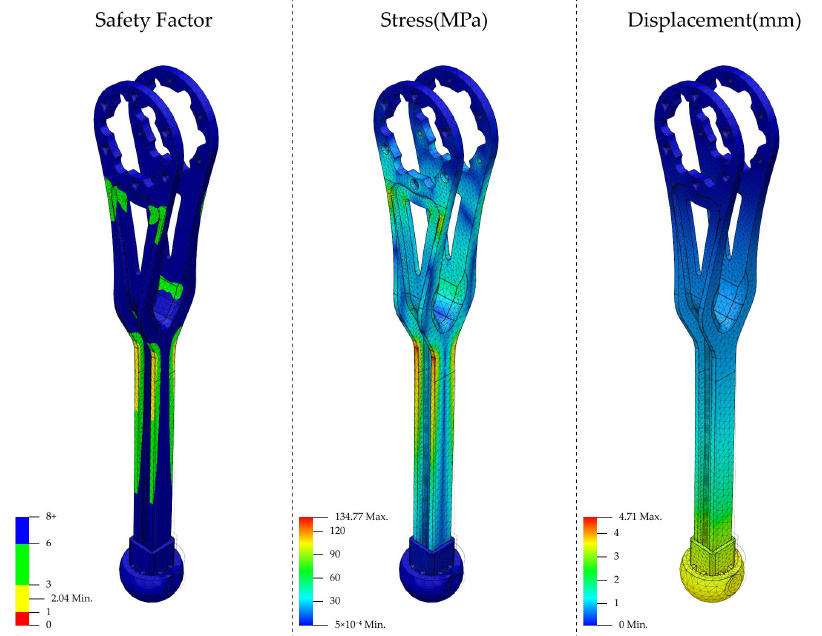
Figure 17. Analysis of condition 1 for the lower link. From left to right are safety factor, stress, and displacement.